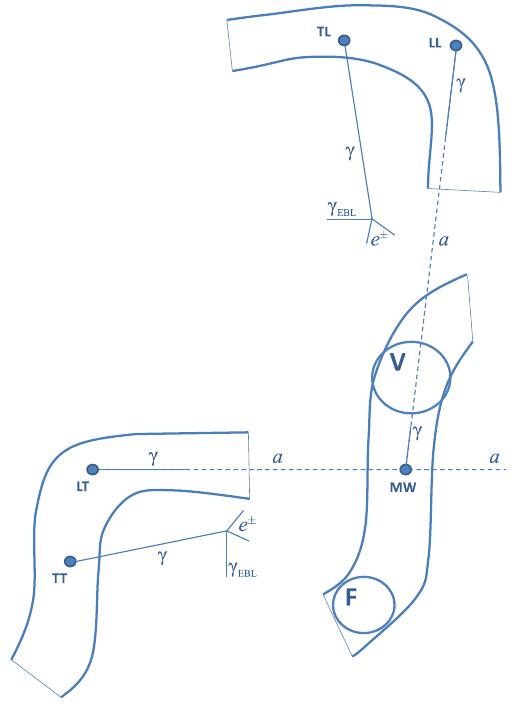
Fig. 4 A sketch (not to scale) of the explanation of the observed anisotropy involving ALP-photon mixing in filaments. The Milky Way (MW) is in the local filament connecting the Virgo (V) and Fornax (F) clusters. Blazars also sit in their local filaments. For sources with the line of sight transversal to their filaments (TT and TL), the photons have no time to convert to ALPs close to the source. If the line of sight goes along the blazar filament (LT and LL), a part of the high-energy photons convert to ALPs there, but only for those coming along our